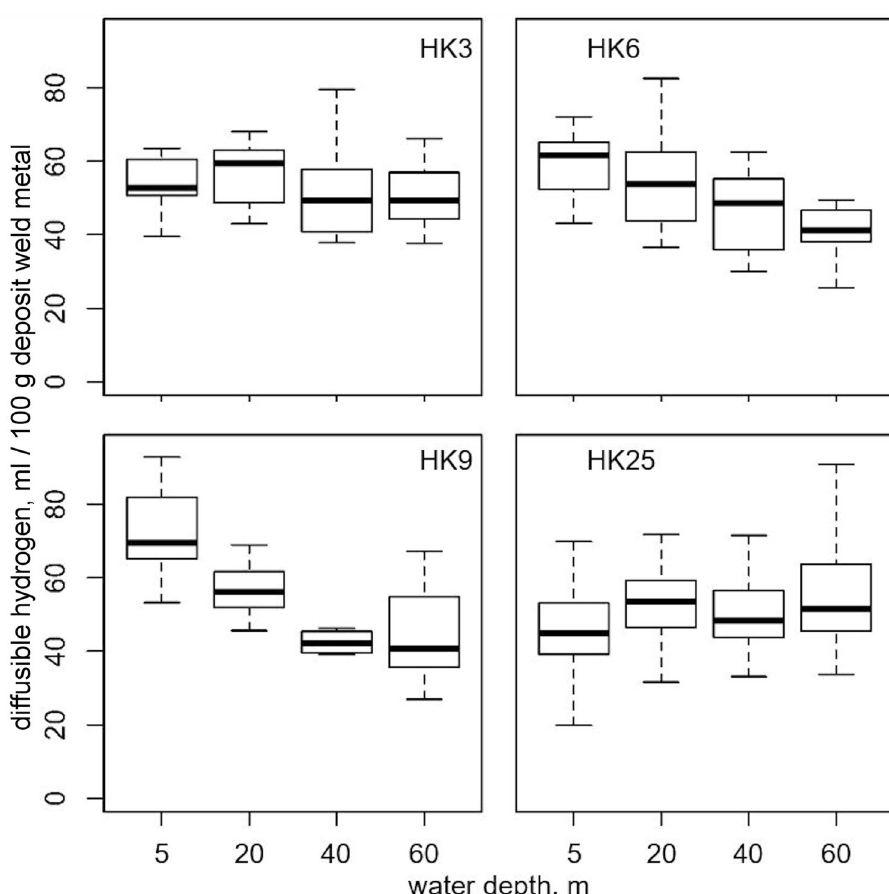
Fig. 5 Boxplots of the diffus- ible hydrogen contents in the deposited weld metal at the four different water depths for all 4 electrodes (HK25 represents all the results of this electrode, regardless of the targeted voltages); the hori- zontal line within the boxes represents the median, the boxes represent the interquar- tile rang. The whiskers show the maximum or minimum of each distribution, provided that they do not deviate more than 1.5 times the interquartile distance from the box (the closest